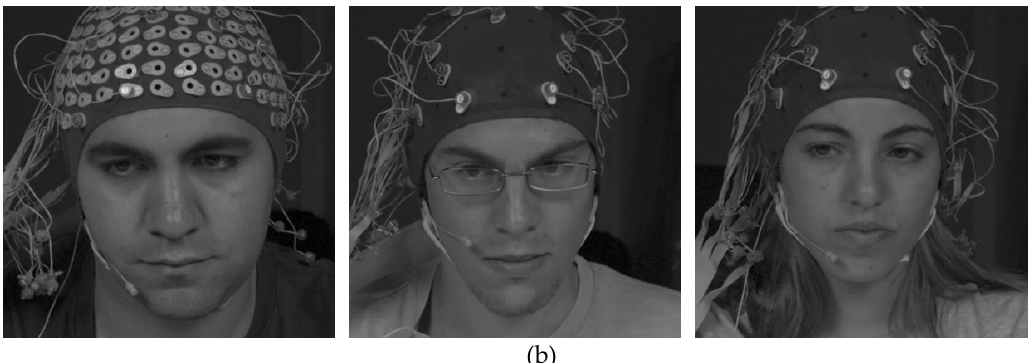
Figure 13. Examples of the facial images from Open database: ( a ) normal emotion; ( b ) aggressive emotion.